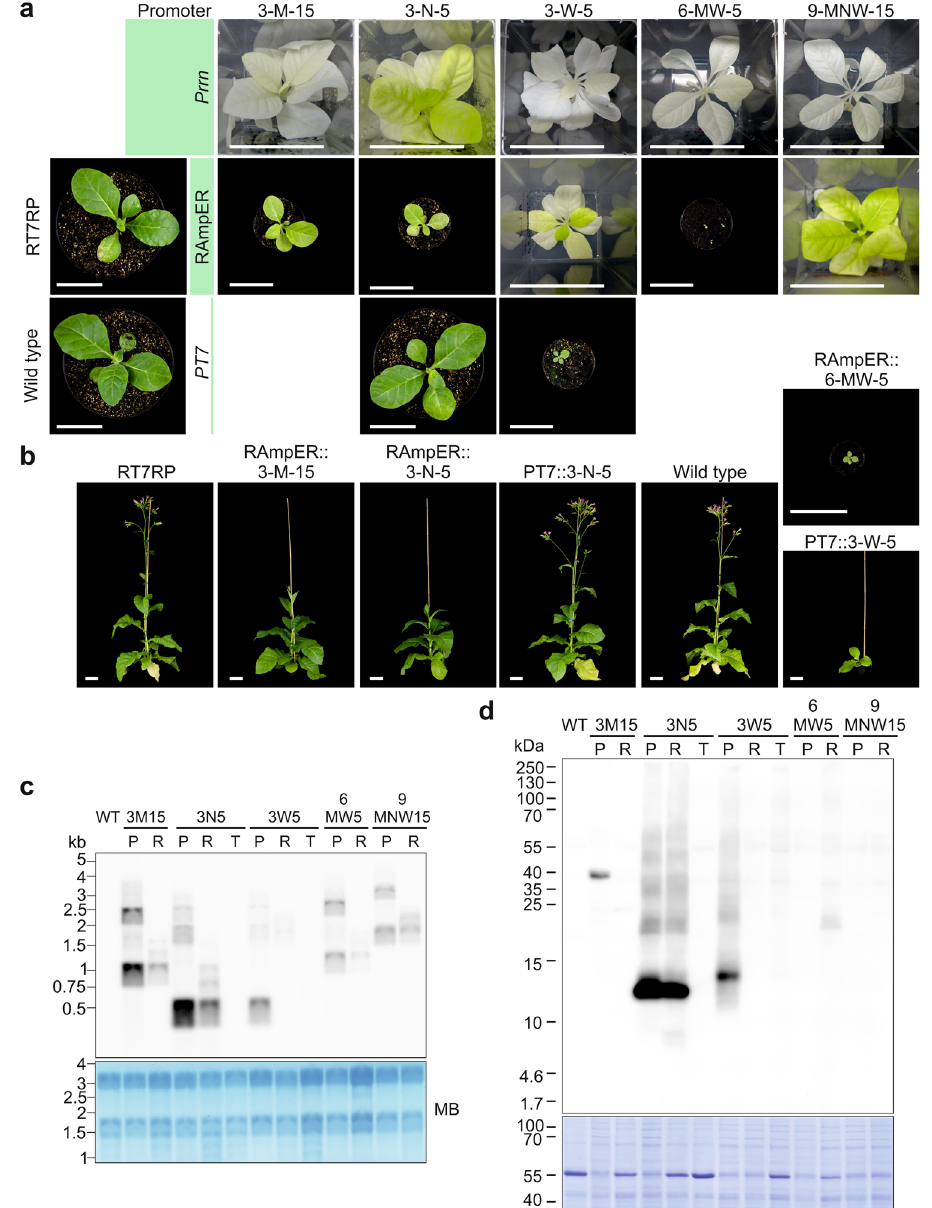
Fig. 4 | Comparison of transplastomic plants expressing fAMP constructs controlled by different promoter systems. a Phenotypes of transplastomic plants.TwogenotypeswereusedasrecipientsforintroductionoffAMPconstructs: thewildtypeandatransplastomiclineharboringtheriboswitch-controlledT7RNA polymerase(RT7RP).ThepromotersusedtodrivefAMPexpressionisgivenineach row. Shown are transplastomic plants expressing fAMPs under the control of the Prrn promoter (images from Fig. 2a), transplastomic plants expressing fAMPs underRAmpERcontrol(uninduced),andtwoPT7-controlledfAMPlinesinthewild- type background. Photos of soil-grown plants were taken one month after sowing. Scale bars: 5cm. 3-M: 3-Molluxubin, 3-N: 3-Novescandin, 3-W: 3-Wamdeposin, 6- MW: 3-M+3-W, 9-MNW: 3-M+3-N+3W. The numbers 5 or 15 indicate the lengths of the amino acid linkers separating the AMPs (see Supplementary Table 1 and SupplementaryData2). b Imagesoftheplantsin(a)twomonthsaftersowing.Scale bars: 5cm. c Northern blot analysis comparing the fAMP expression levels in Prrn